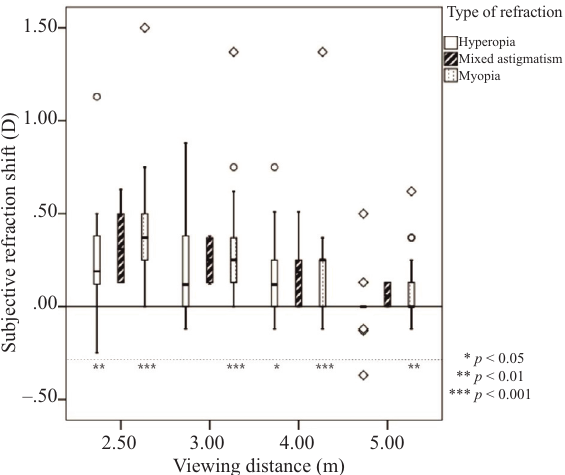
Viewing distance Fig. 2. The refraction shifts (the difference between subjective refraction at 5 m, 4 m, 3 m, and 2.5 m distances if compared to subjective refraction at 6 m distance) for maximum subjective refraction which ensures the best visual acuity in three refraction groups: the hyperopia group, the mixed astigmatism group, and the myopia group. Empty rings and diamonds represent outliers. Stars represent data with statistically significant refraction shifts compared to 6 m viewing distance.